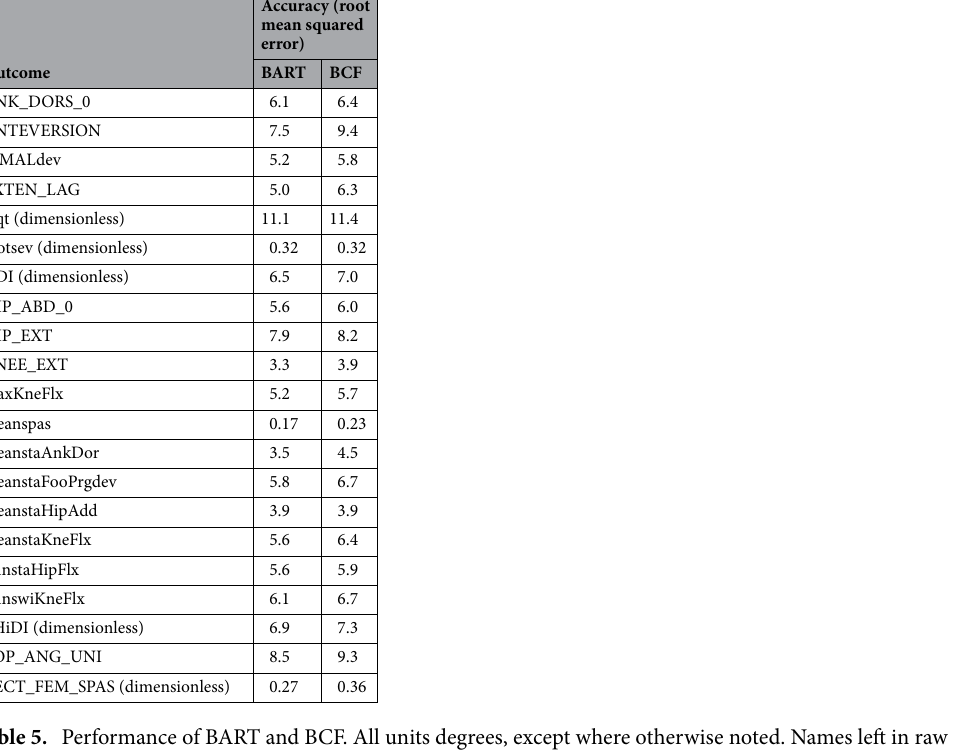
Table 5. Performance of BART and BCF. All units degrees, except where otherwise noted. Names left in raw form, see Appendix 1 for covariate name